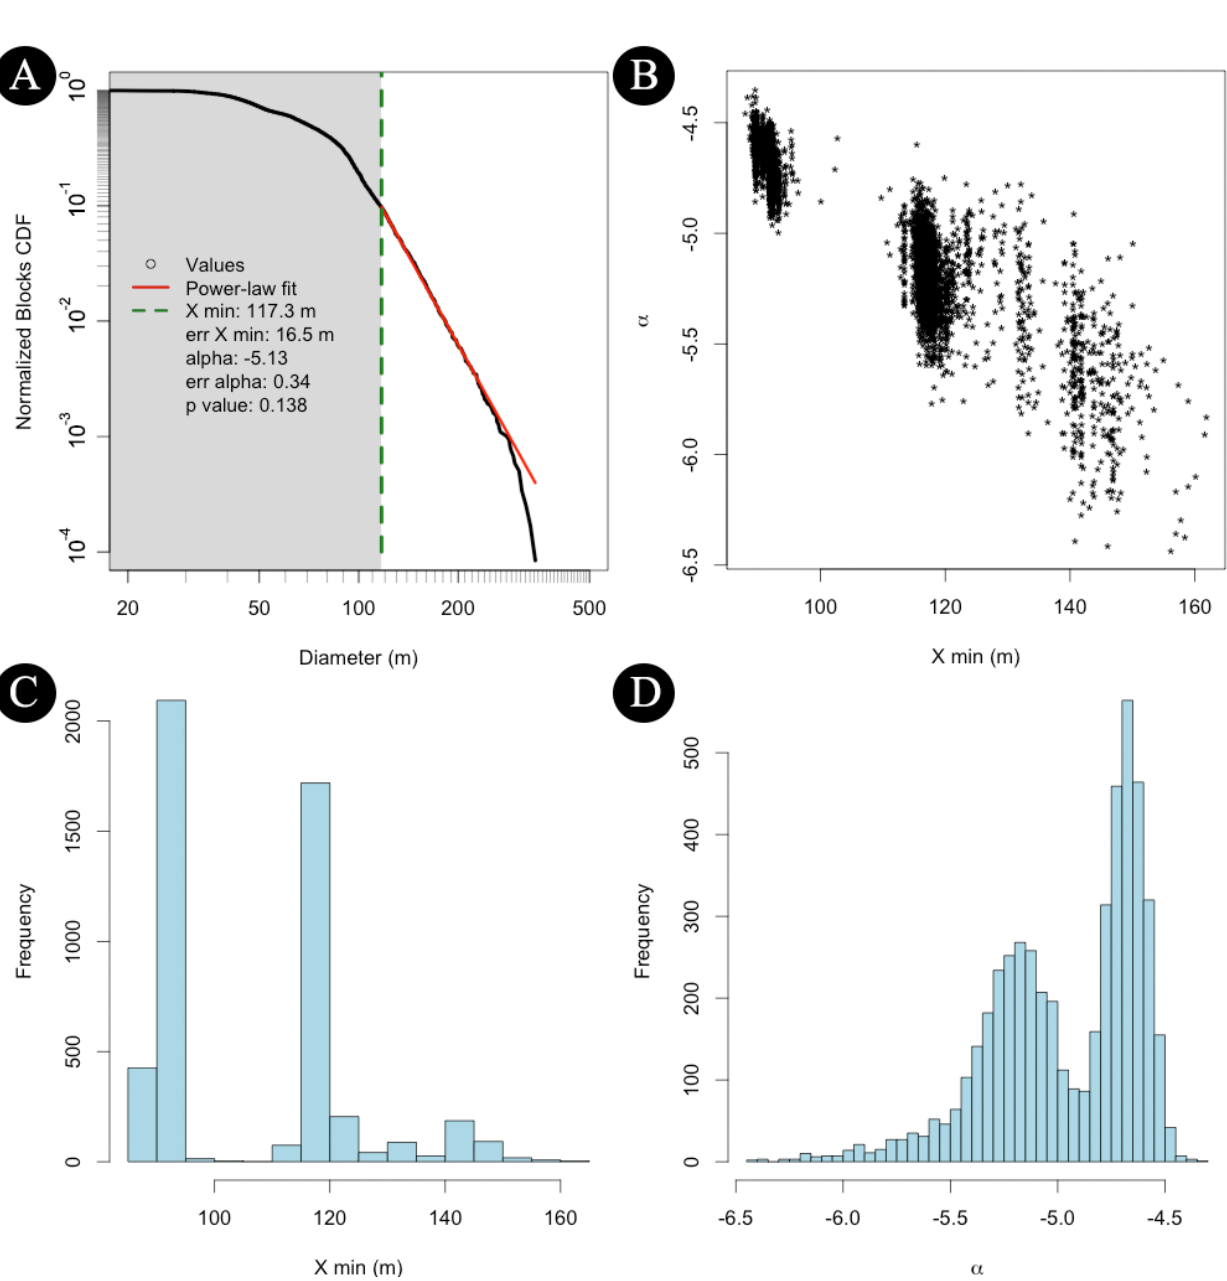
Figure 10. The Baghdad case study. ( A ) Normalized cumulative distribution function showing the obtained sizes, the power-law fitting curve and the x min limit (the grey shadowed area is not considered by the fit). The total number of blocks larger than x min and used for the fit is 1156. ( B ) Scatter-plot of x min against 𝛼 resulting from 5000 synthetic datasets. ( C ) Frequency histogram of x min . ( D ) Frequency histogram of the power-law index 𝛼 .